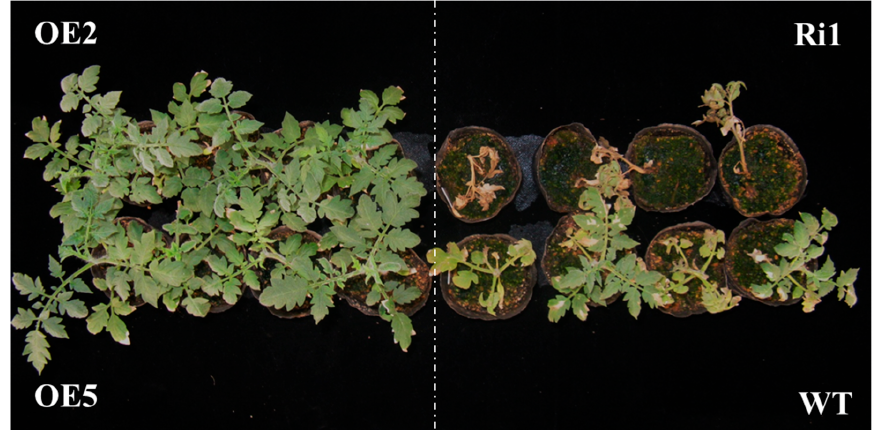
Figure 5. Seedling phenotype of tomato with overexpressed PKE1 (OE) and RNAi knockdown (Ri) under salt stress conditions. Four-leaf stage seedlings for salt treatment initiated by watering 200 mM NaCl for 14 d. Int. J. Mol. Sci. 2019 , 20 , x FOR PEER REVIEW